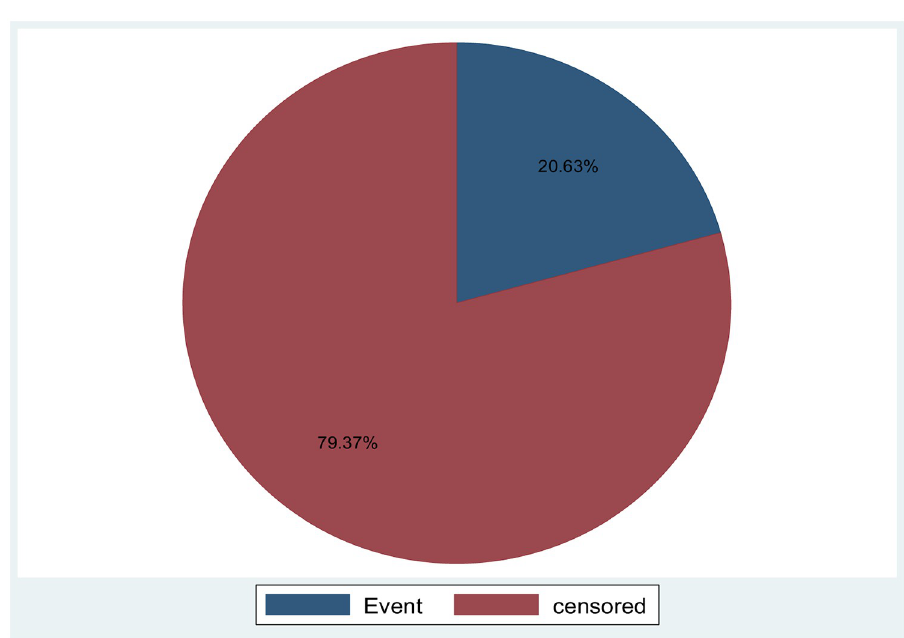
Fig 1. Outcomes of adult type two diabetes mellitus patients Amhara region Comprehensive Specialized Hospital, Northwest Ethiopia, 2022 (n =